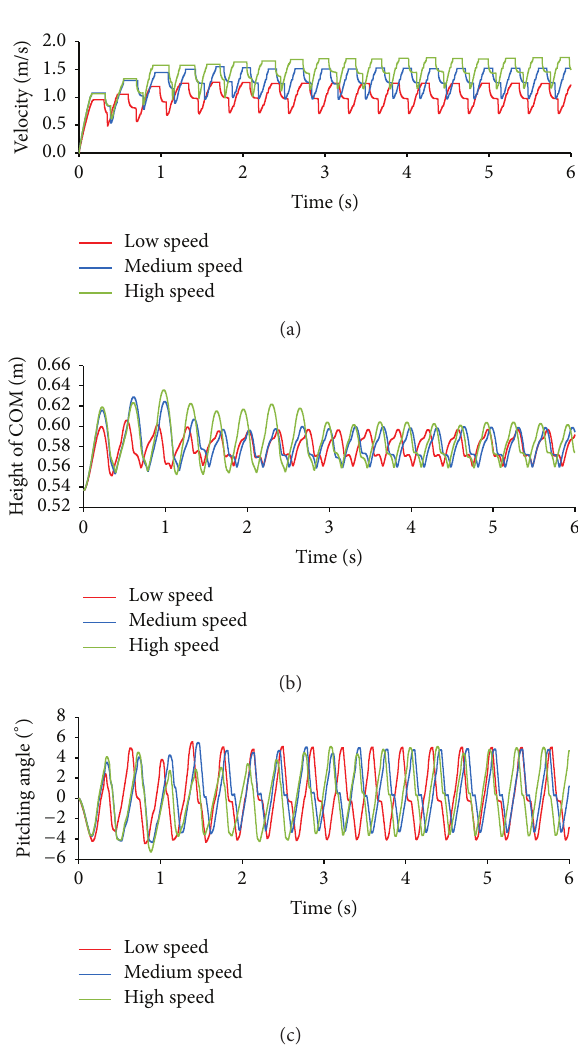
Figure 9: Kinematic variables under different parameters.